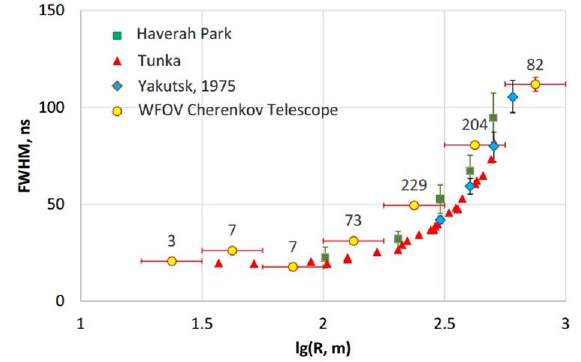
Figure 1. : Full width at half-maximum of the Cherenkov signal as a function of the shower core distance, R, measured by EAS